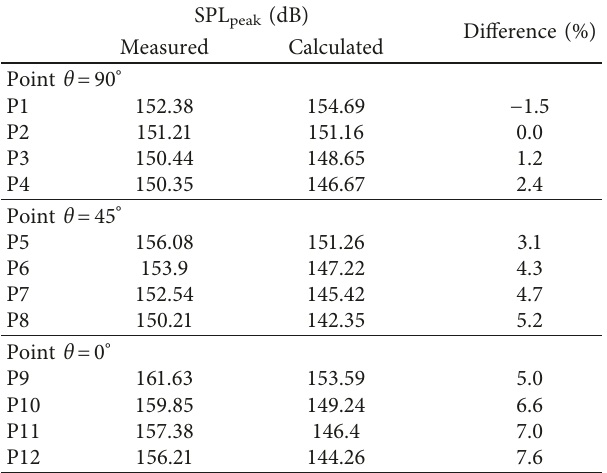
Figure 17: One-third octave frequency spectrum. Comparison between cases with and without the muzzle brake. (a) Point 1 at θ � 90 ° and r � 1.0m. (b) Point 5 at θ � 45 ° and r � 1.0m. (c) Point 9 at θ � 0 ° and r � 1.0m. Table 2: Comparison between the calculated and experimental results of SPL peak